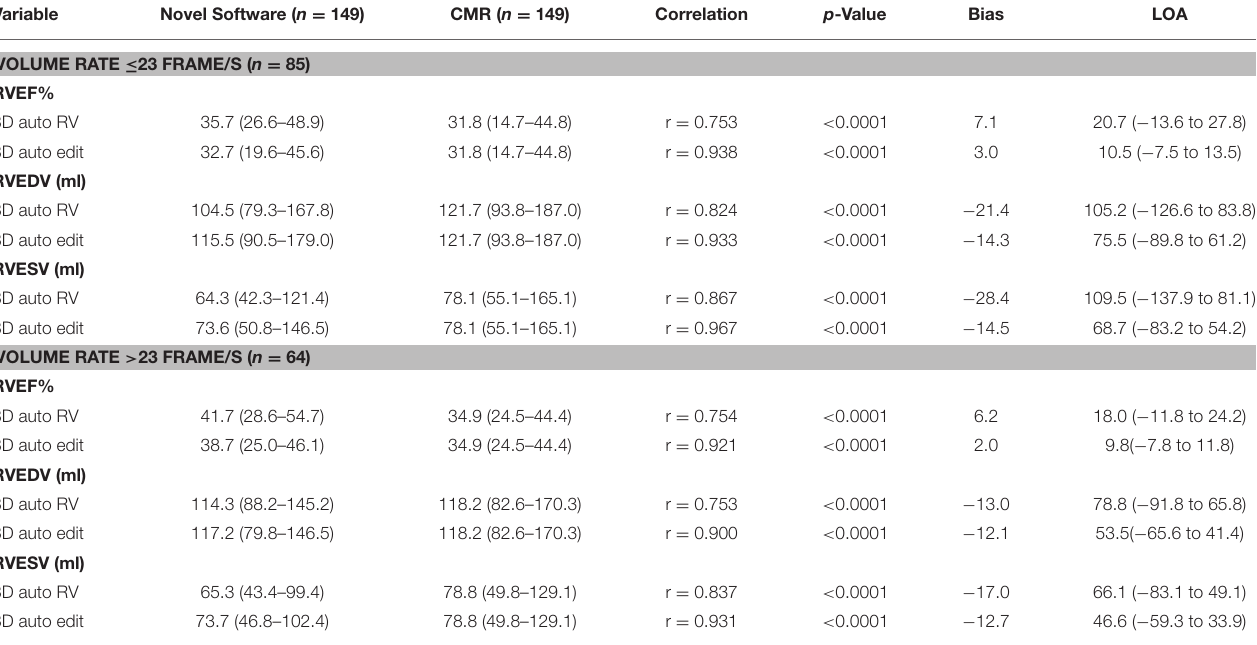
TABLE 5 | The effects of frame rate (FR) on 3D auto RV quantification with/without manual editing compared with